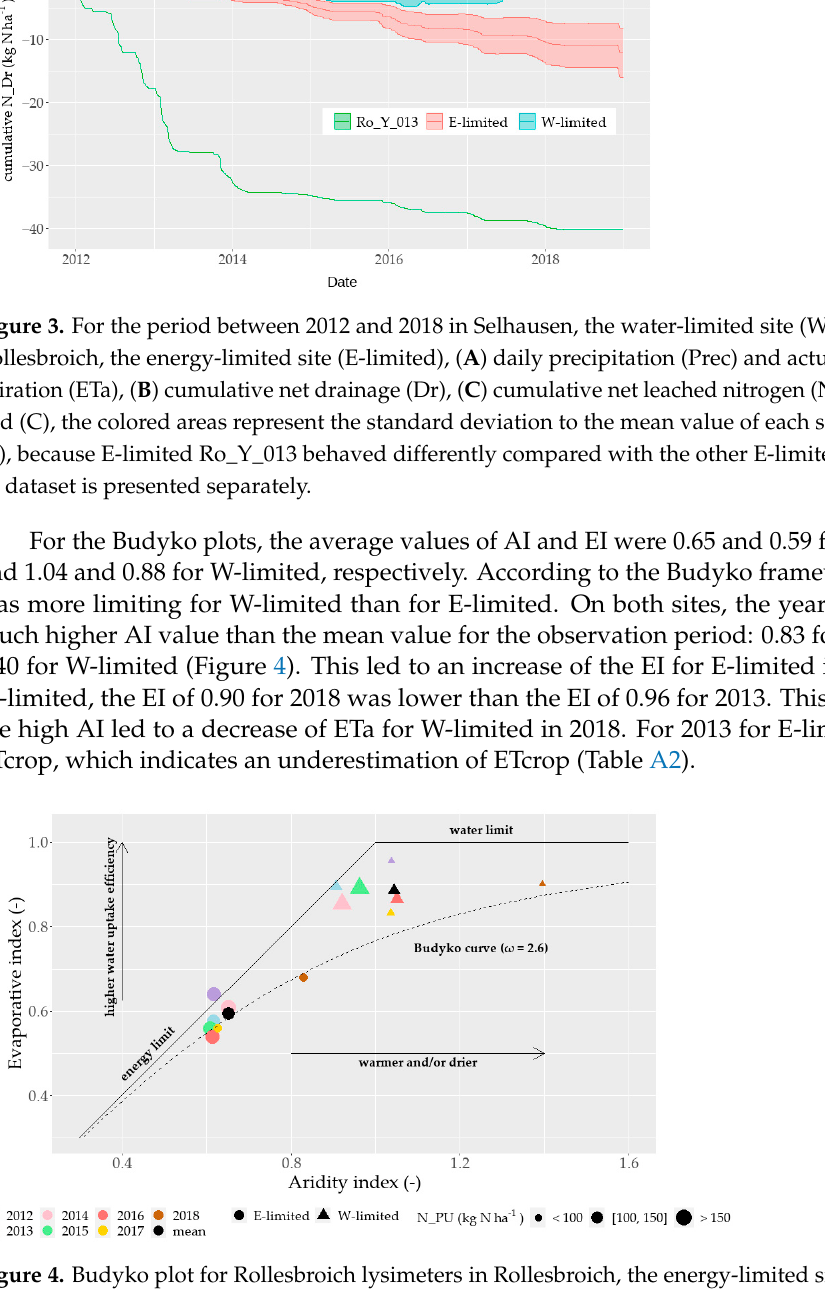
Figure 4. Budyko plot for Rollesbroich lysimeters in Rollesbroich, the energy-limited site (E-lim- circles) and in Selhausen, the water-limited site (W-limited, triangles) for the period 2012–2018. The aridity index (x-axis) is the ratio of the cumulated yearly grass height-adjusted reference evapotran- spiration to the available water, defined as precipitation and ground water contribution, following the recommendation of Condon and Maxwell [53]. The evaporative index (y-axis) is the ratio of the cumulated yearly actual evapotranspiration to the water input. The points’ size correspond to the annual plant nitrogen uptake (N_PU). “mean” in the legend indicates the mean annual values for the period 2012–2018. The dotted curve shows an exemplary Budyko curve, with Fu’s parameter [55] taken from Rahmati et al. [37]— ω = 2.6. The diagonal black line is the energy limit for the actual evapotranspiration—actual evapotranspiration is equal to potential evapotranspiration. The horizon- tal black line is the water limit for the actual evapotranspiration—actual evapotranspiration is equal to the available